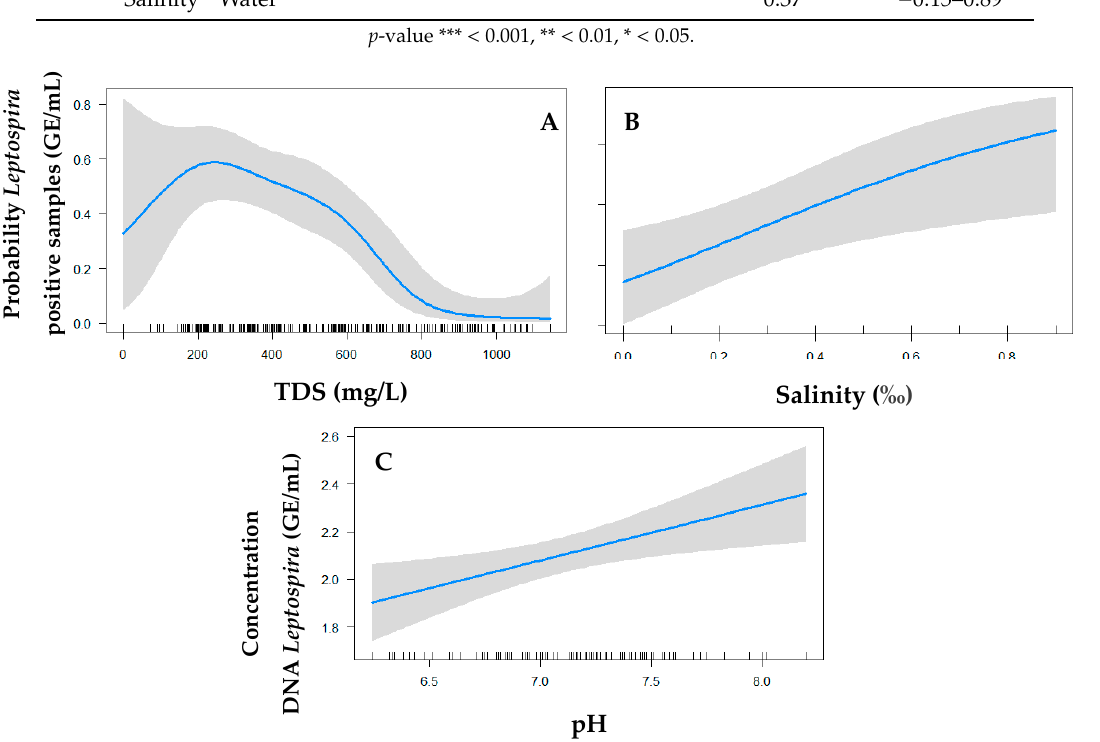
Figure 1. Probability of finding Leptospira positive water samples in the final logistic model according to TDS ( A ) and salinity ( B ). Probability of finding Leptospira DNA concentration water samples in the final linear model according to pH ( C ). The blue line denotes the predicted chance/probability and the grey area the 95% confidence interval. Ticks on the X -axis denote individual measurements.